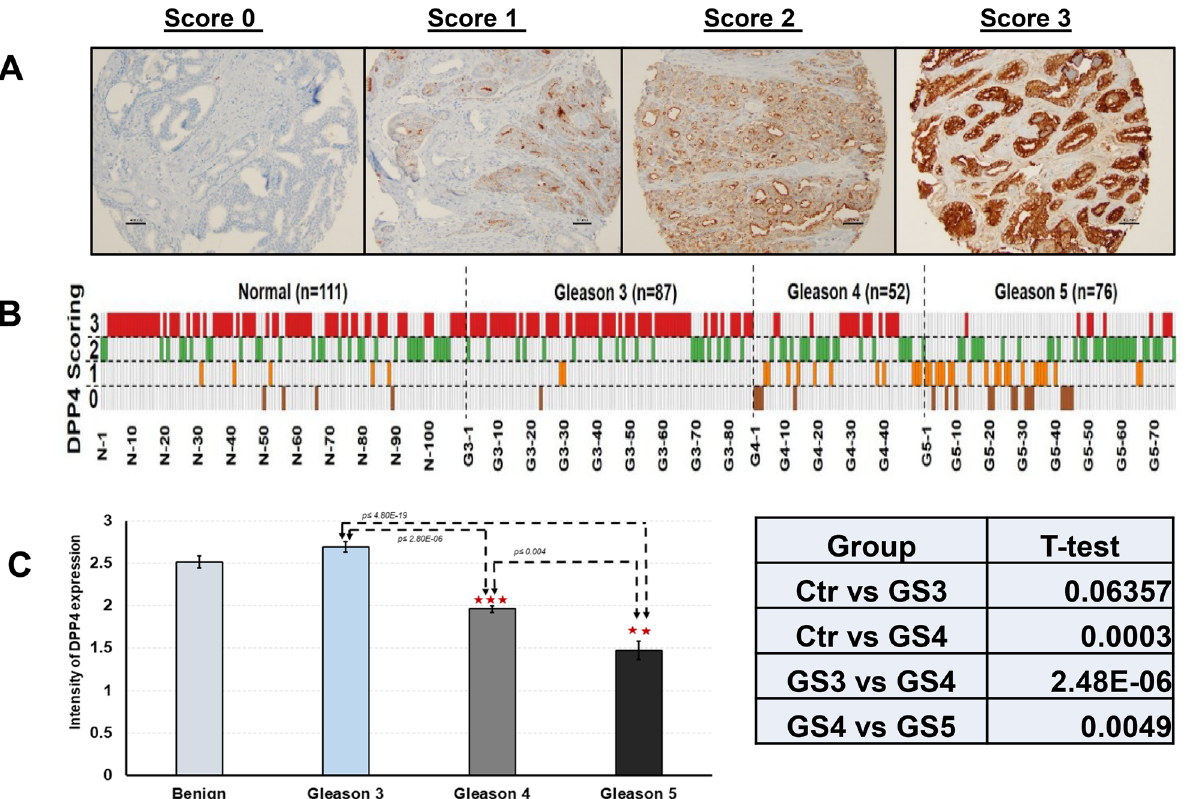
Figure 6. IHC staining of DPP4 expression in PCa tumor tissue microarray (TMA). ( A ) A semi-quantitative 4-tire scoring system in tumor cells: 0 (0%, no staining), 1 (< 10%, weak and focally staining), 2 (10–50%, medium and focally staining), or 3 (> 50%, strong and diffusely staining). ( B ) Correlation of DPP4 expression with Gleason scores in tumors and tumor-matched benign controls. ( C ) Comparison of DPP4 expressional pattern in tumors and tumor-matched benign controls. * P < 0.05; ** P < 0.01, *** P <